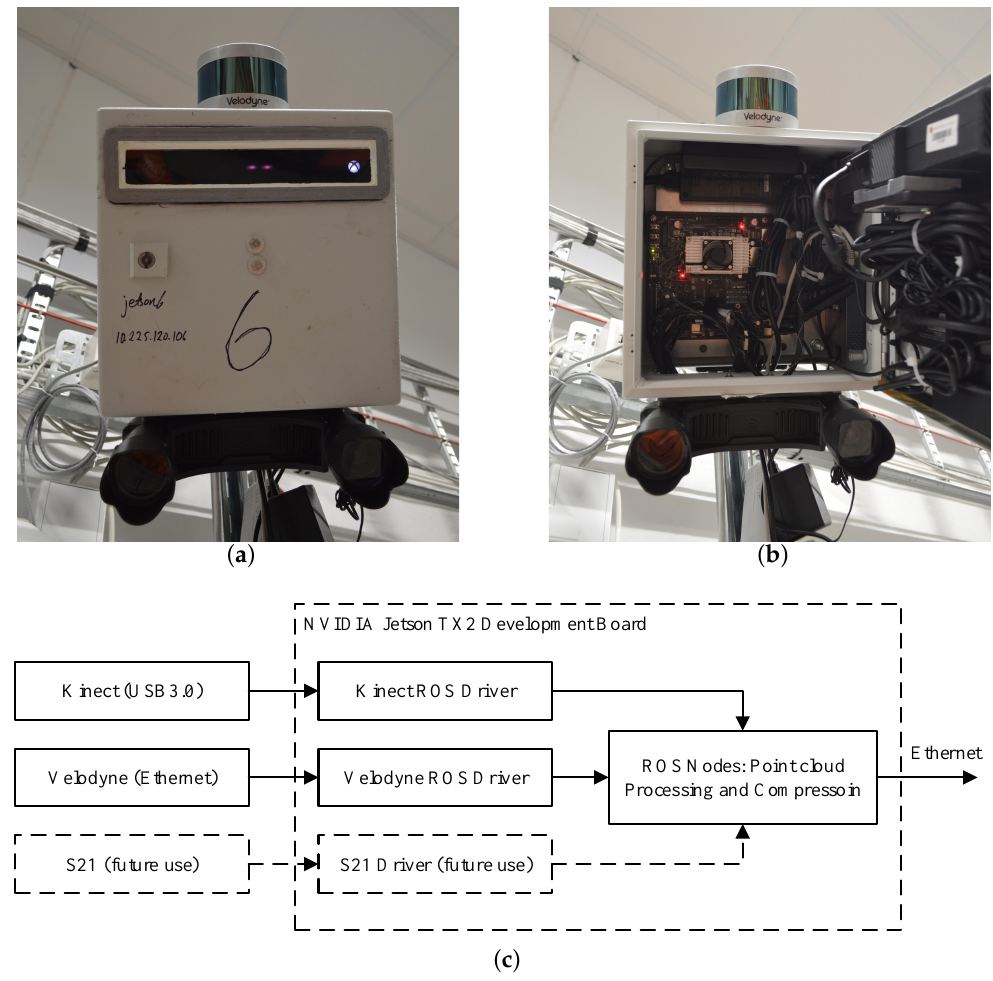
Figure 9. ( a , b ): embedded sensor node consisting of an NVIDIA Jetson TX2 Development Board, a Kinect V2 depth sensor, a Velodyne VLP-16 PUCK Lidar and a Carnegie Robotics S21 stereo camera for future experiments; ( c ) schematic overview of the NVIDIA Jetson TX2 hardware connections